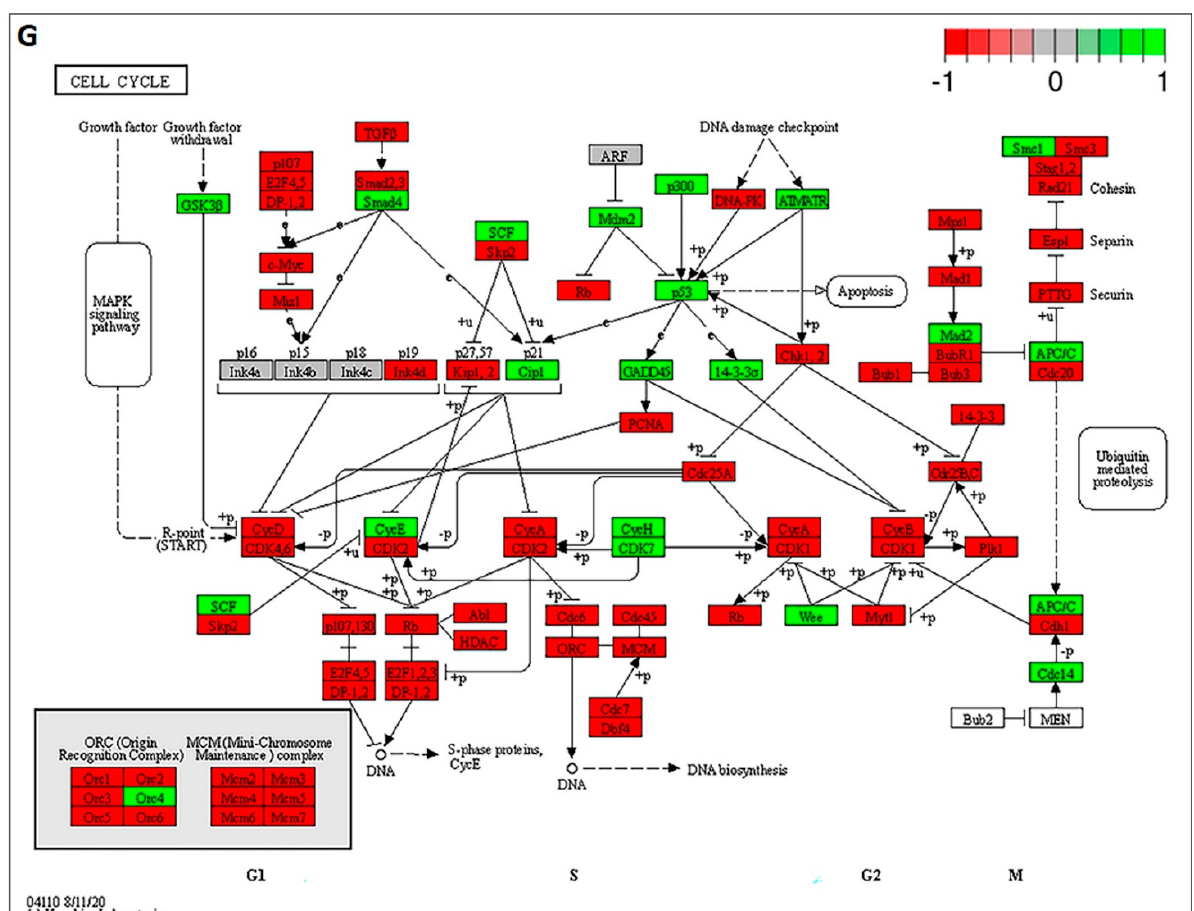
Figure 7. ( A ) Gene set enrichment analysis of pathways enriched in U87-MG cells after treatment with CAP + TMZ. ( B , C ) Dot and ridge plots of top 10 altered processes in most enriched pathways. ( D ) Heatmap comparison of upregulated genes (relative to control) of the cell cycle signaling pathway in U87-MG cells post-treatment with CAP, TMZ, or CAP + TMZ. ( E ) Heatmap comparison of downregulated genes of the cell cycle signaling pathway in U87-MG cells post-treatment. ( F ) Gene set enrichment analysis of the cell cycle pathway using the Reactome database resulted in a Normalized Enrichment Score (NES) = − 1.79, Nominal p -value = 0.025. A negative NES indicated cell cycle gene sets are downregulated and negatively correlated. ( G ) KEGG pathway analysis of cell cycle genes regulated by CAP + TMZ in U87-MG cells.